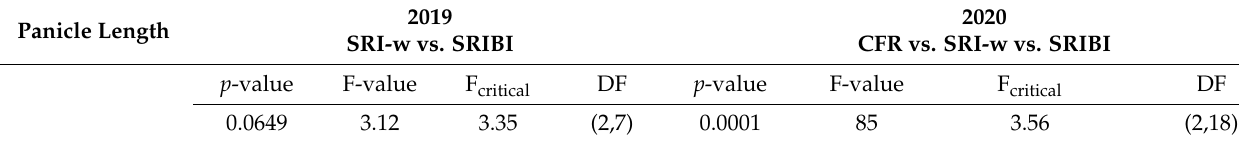
Figure 4. Averagepanicle length of the different treatments as observed in field experiments ( Left: 2019; Right : 2020).